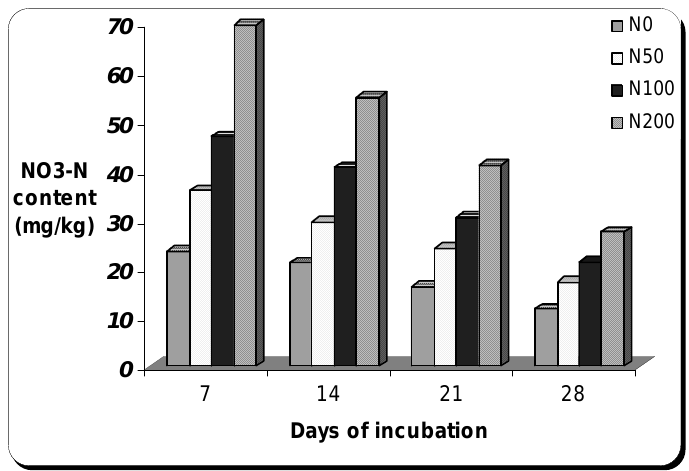
FIGURE 8 . Mean effect of different levels of N on the changes in NO 3 -N content under saturated